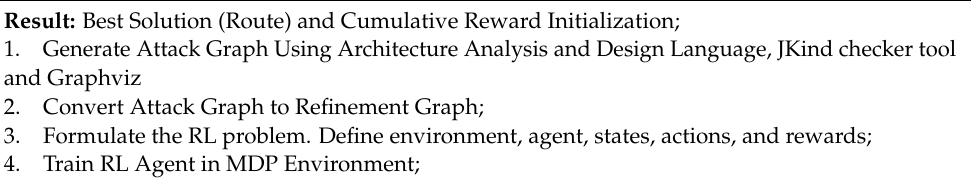
Algorithm 1. Used Approach